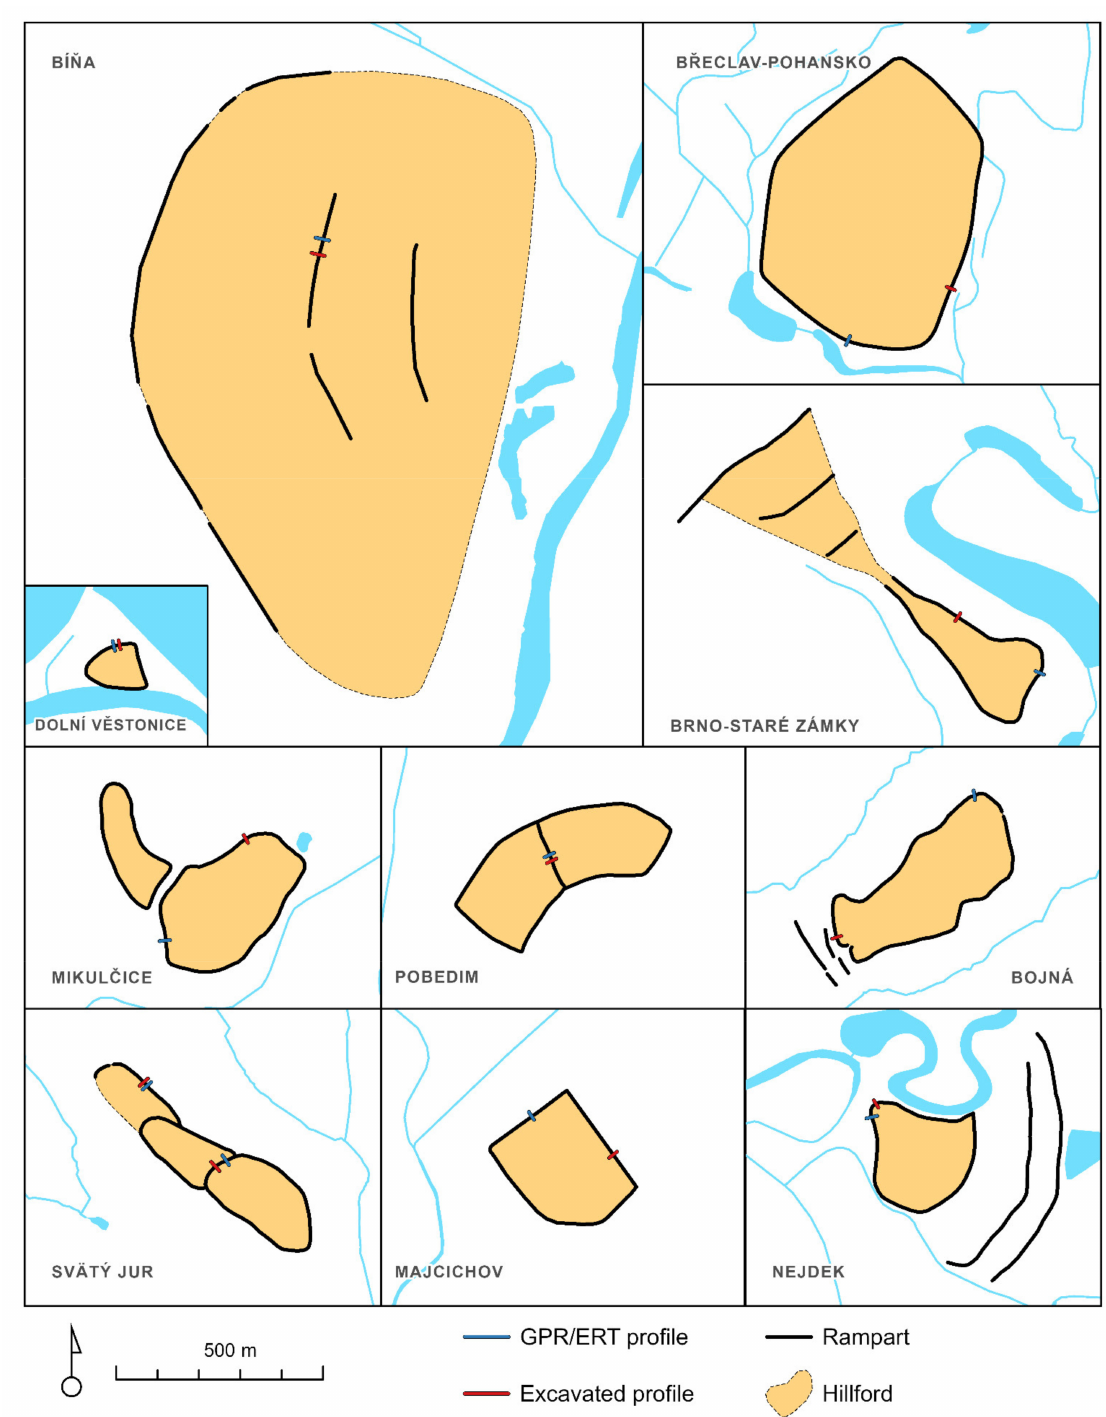
Figure 2. Layout plans of the fortified settlements with locations of archaeological trenches and ERT and GPR profiles are discussed in the